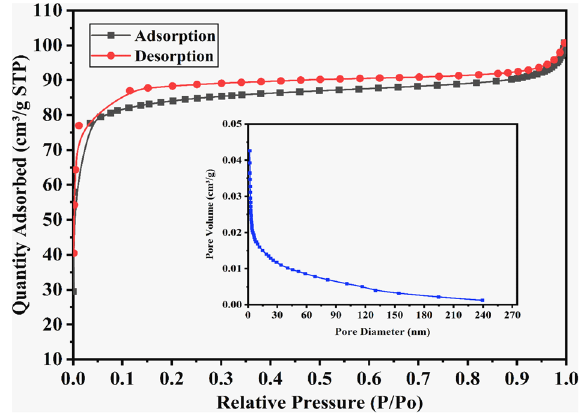
Figure 1. N 2 adsorption–desorption isotherms and the pore diameter (inset) for WAS-BC.